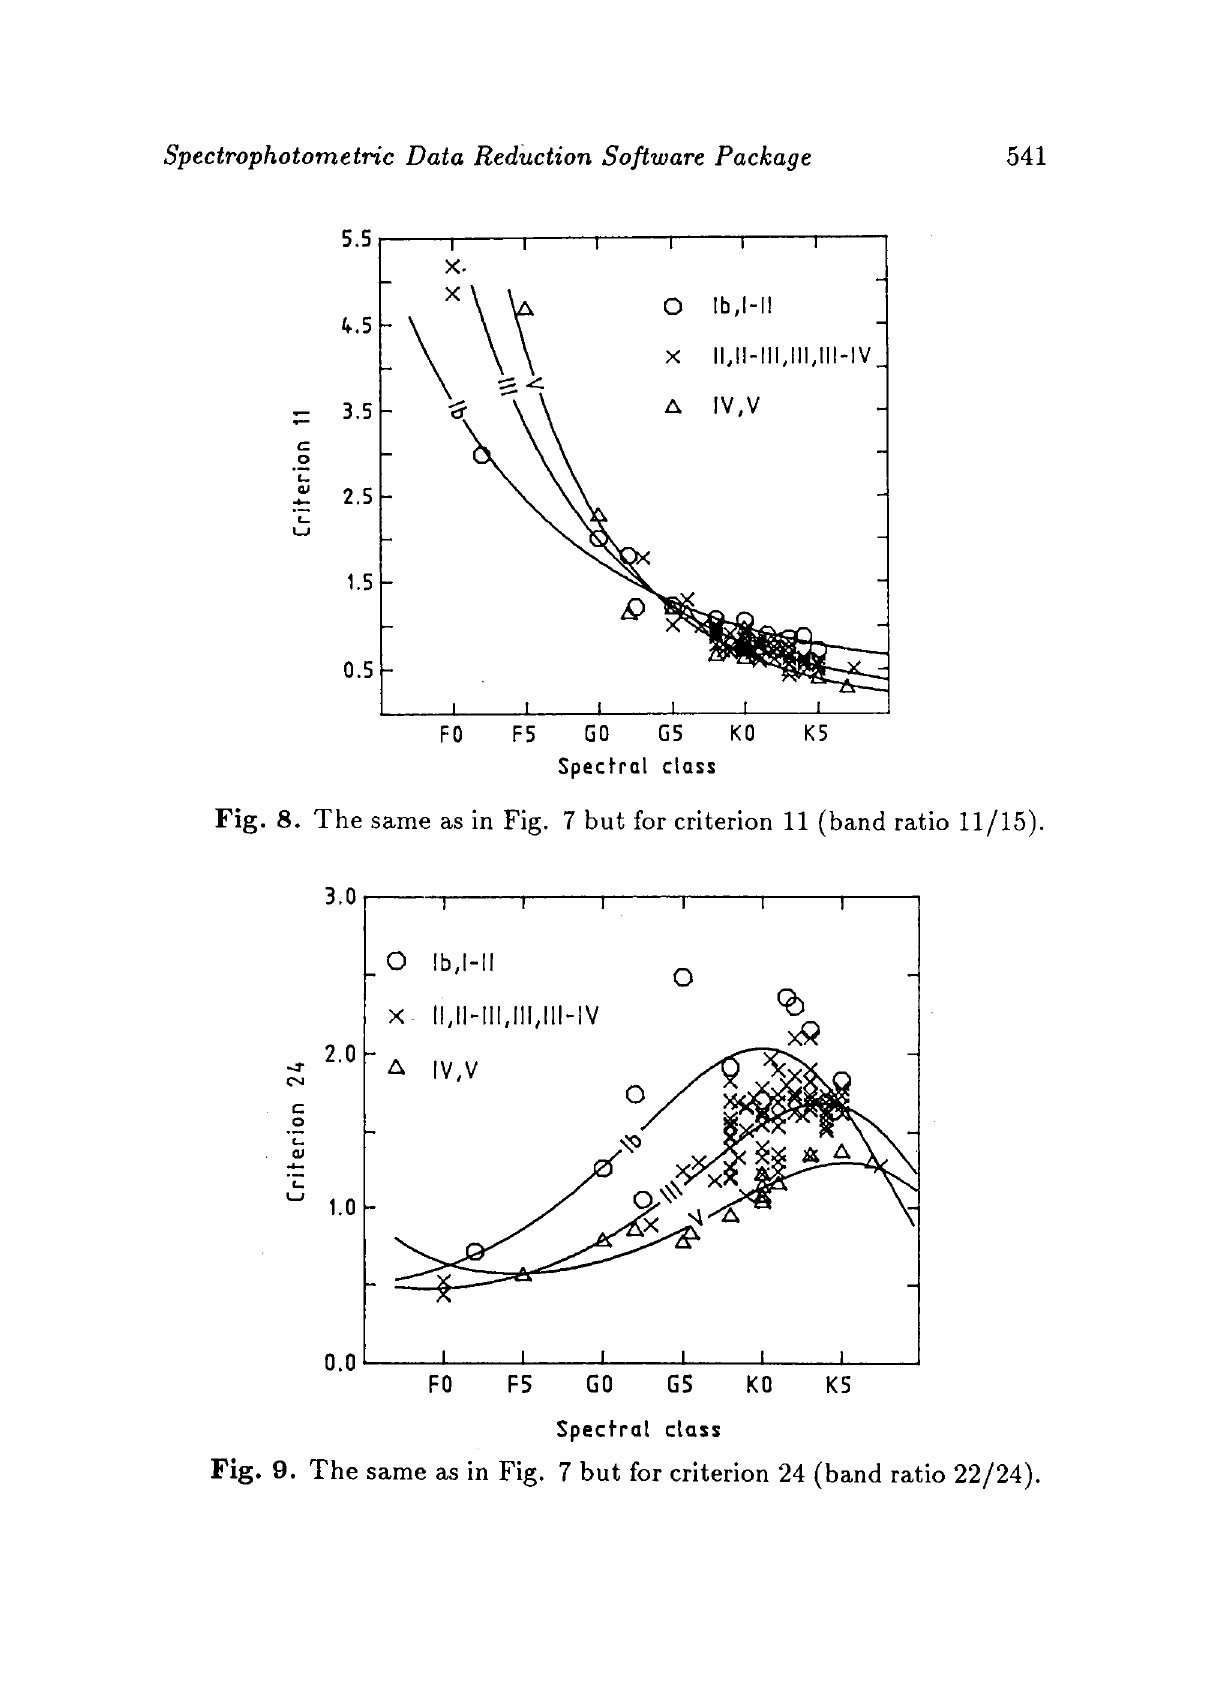
Fig. 9. The same as in Fig. 7 but for criterion 24 (band ratio